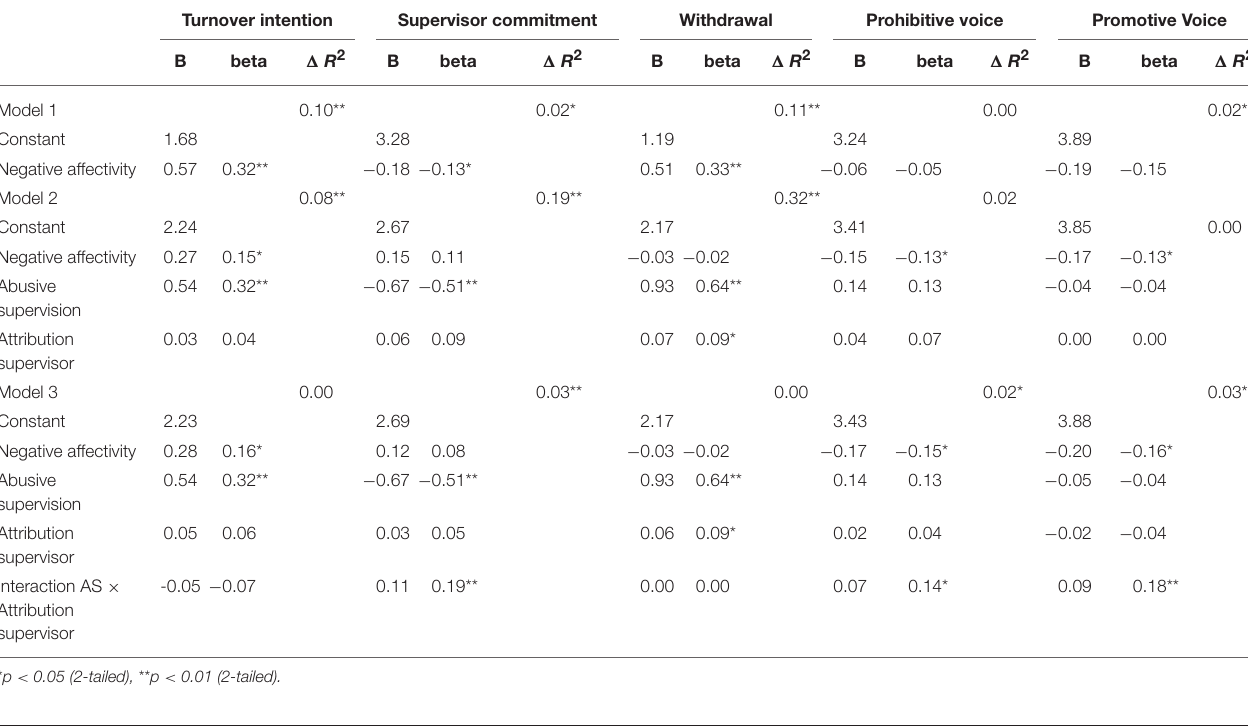
TABLE 8 | Moderated regression analyses attribution to supervisor and reactions (Study 3). Turnover intention